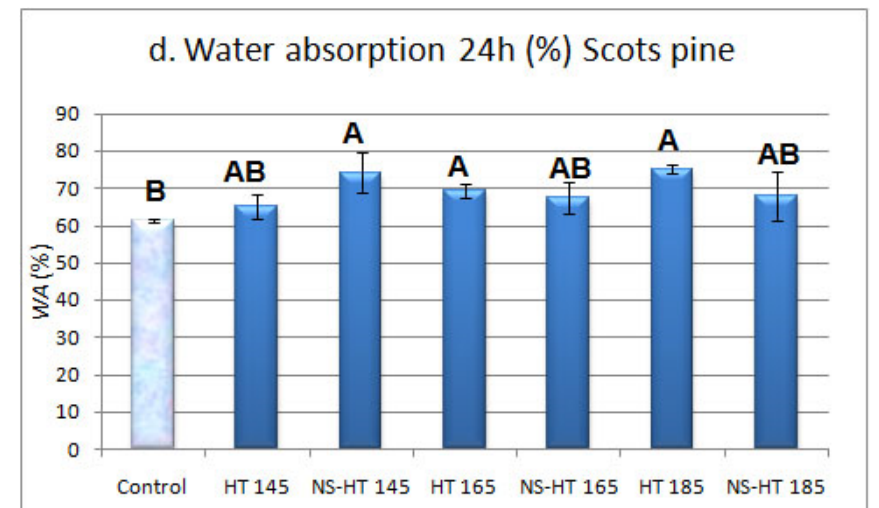
Figure 4. Physical properties of volumetric swelling after 2 h (a) and 24 h (b), as well as water absorption after 2 h (c) and 24 h (d), in Scots pine specimens heat ‐ treated at 145, 165, and 185 °C and impregnated with silver nanosuspension. (HT = heat ‐ treated at a determined temperature; NS = nano ‐ silver impregnated. Letters on each column represent statistical groupings of mean values based on Duncan’s Multiple Range test at 95% level of confidence. Error bars represent standard deviation).